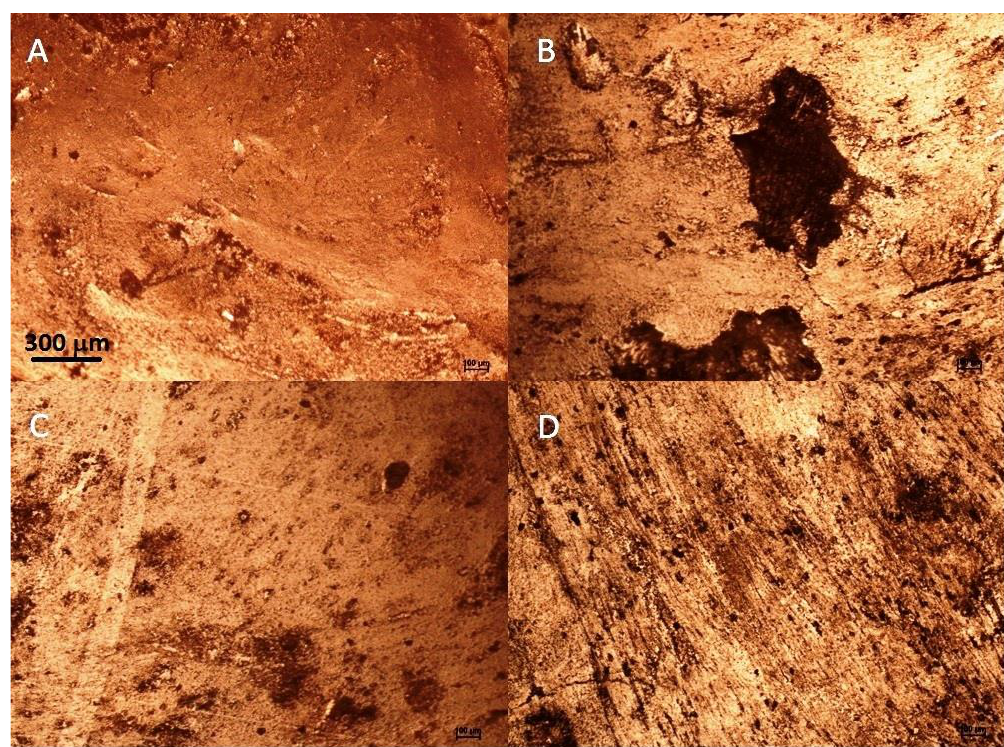
Figure 5. Microstructure of gluten obtained from wheat cultivated after barley as a forecrop observed using a polarizing optical microscope. ( A ) — organic unsonicated; ( B ) — organic sonicated; ( C ) — conventional unsonicated; ( D ) — conventional sonicated.